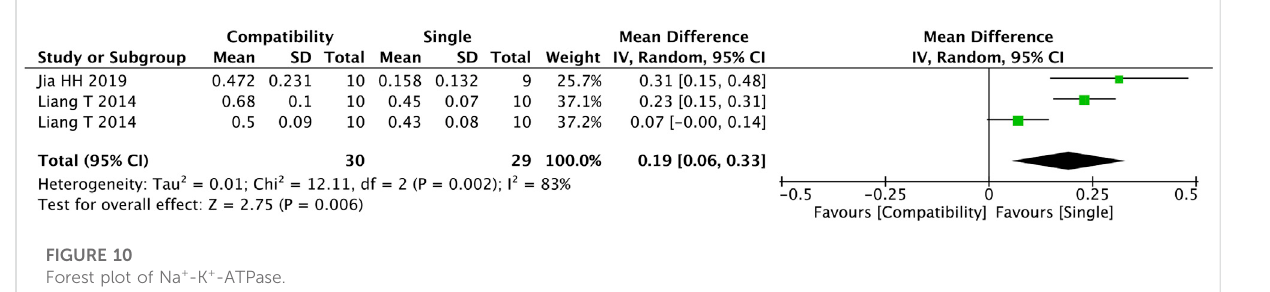
FIGURE 10 Forest plot of Na + -K +